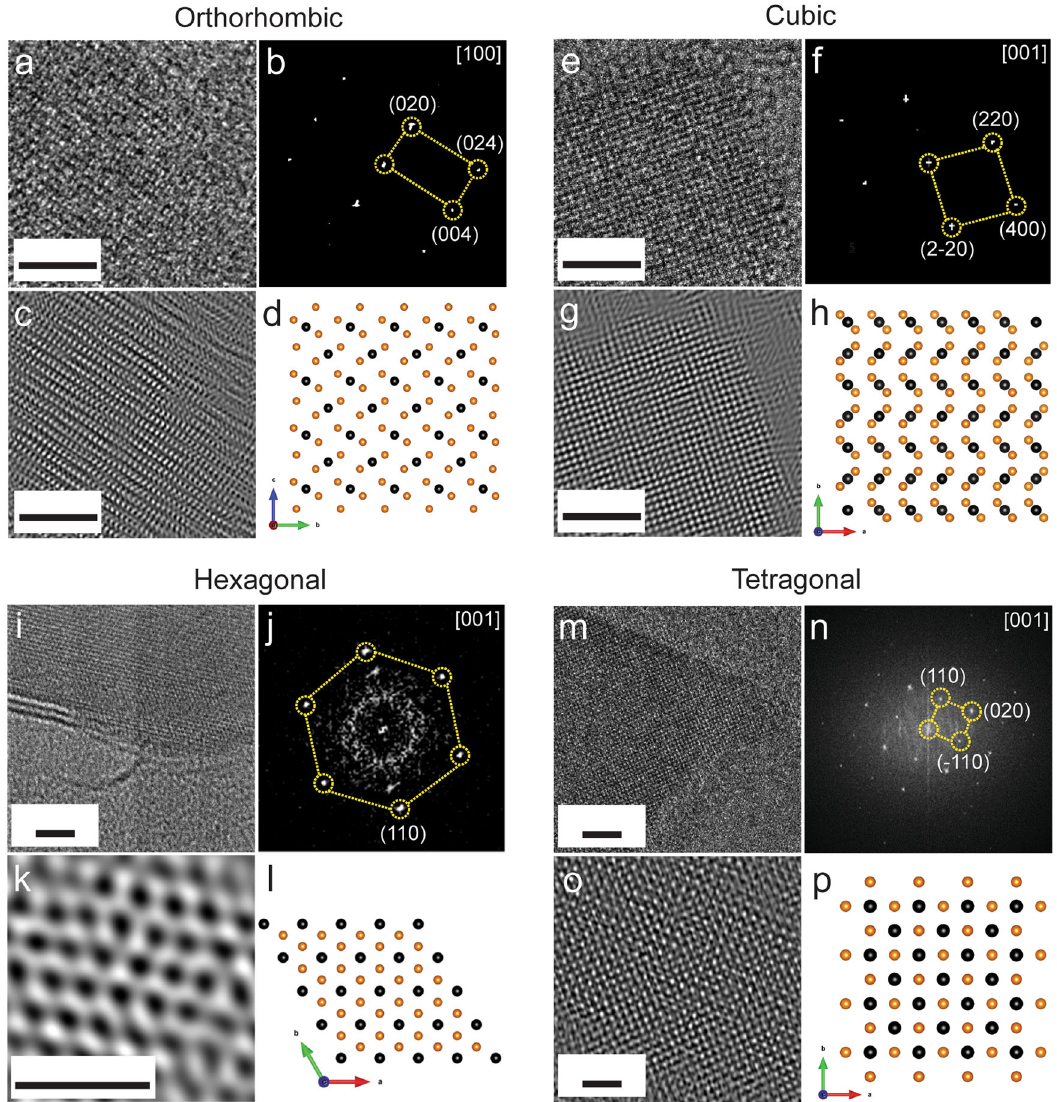
Fig. 3 Structural analysis of CoSe 2 and CoSe phases. a – d Orthorhombic and e – h Cubic-CoSe 2 . i – l Hexagonal and m – p tetragonal-CoSe. a , e , i , m are HR-TEM images; b , f , j , n are FFT patterns of the images; c , g , k , o are fi ltered images; d , h , l , p are schematic atomic models of the corresponding structures. FFT patterns without mark-up are provided in Supplementary Fig. 15 of the SI. All scale bars indicate 2 nm, except for the scale bar in panel k which indicates 1 This value was strongly overestimated when using the standard wave approach 36,37 and the generalized gradient approximation GGA-PBE functional because of the neglect of van der Waals (GGA) with the exchange-correlation functional by Perdew, Burke interactions, while better agreement was found when using the and Ernzerhof (PBE) 38 . The structures were also evaluated using a optB88-vdW functional (Supplementary Table 4). For this reason, van der Waals density functional (optB88-vdW) 39,40 . Computa- we show in Fig. 6b the relative stability of all phases calculated tional details are provided in the “ Methods ” section. using opB88-vdW. The formation energies of all phases are listed Figure 6a provides an overview of the crystal structures of all in Supplementary Table 4 and the DFT-optimized crystal structures phases involved in the transformations. Transformation (1) where are provided as Supplementary Data as well. the orthorhombic-CoSe 2 phase transforms into the cubic-CoSe 2 The formation energies displayed in Fig. 6b were calculated as phase was already described above, and can be explained from E form Co rotations of metal-chalcogen chains 20 . The subsequent transfor- are expressed in eV/atom; E (Co x Se y ) is the energy of the particular mation (2), from c-CoSe 2 to h-CoSe, and transformation (3), from h-CoSe to t-CoSe, are experimentally observed in the present compound, and E (Co) and E (Se) are the energies of the elemental work. The intermediate phase that was observed during phases of Co and Se, respectively. All formation energies displayed transformation (2) may correspond to the Co 3 Se 4 structure 41 and in Fig. 6b are thus de fi ned with respect to the elemental phases, and are plotted as a function of their composition. The black line is we have included this phase in the computations. The sequence the common tangent line connecting the most favorable phases. ends with the tetragonal t-CoSe phase which clearly consists of 2D It is clear that the transformation sequence displayed in Fig. 6a is atomic planes that are stacked along the c -axis. The experimental feasible from the point of view of the total energies: The o-CoSe 2 value of its c lattice parameter is 5.25 Å (Supplementary Table 2).